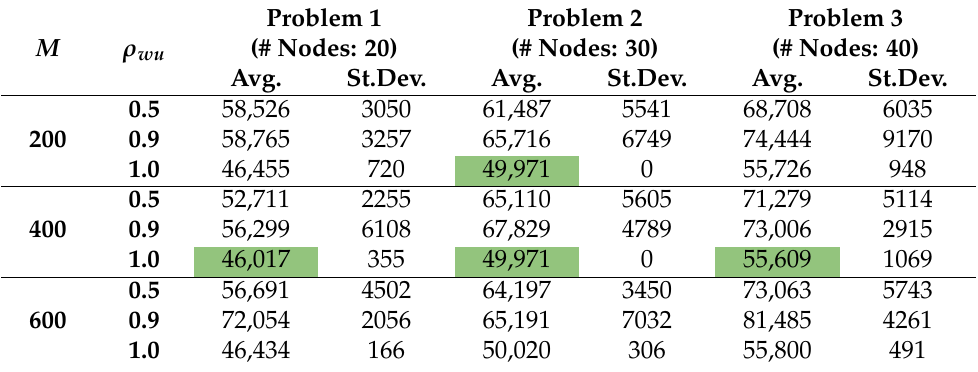
Table 1. Parameters’